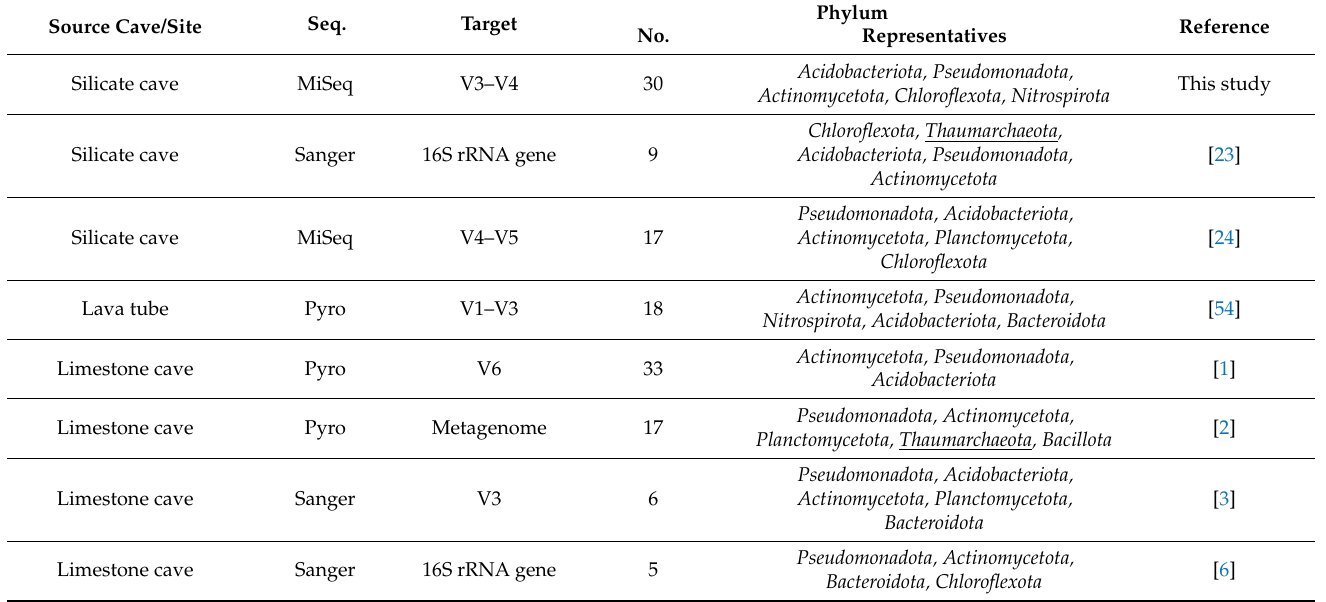
Table 5. Comparison of representative phyla reported from silicate caves, a lava tube, limestone caves, and building walls. Sequencing methods (Seq.), target sequences, and numbers of reported phyla of domains Bacteria and Archaea . Archaeal phyla are underlined. The sequencing method of “Pyro” indicates 454 pyrosequencing. Phylum names are updated according to the latest valid names [61]. Archaeal phyla are